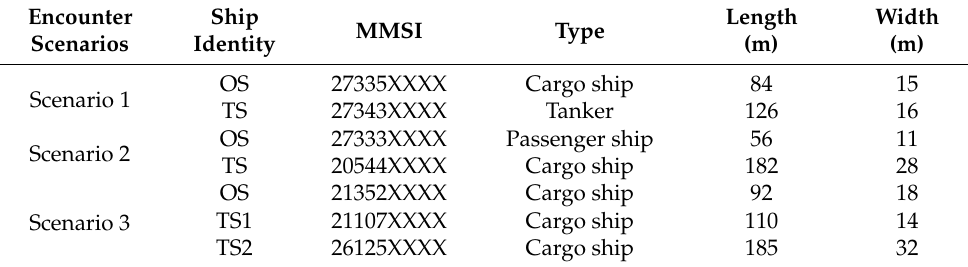
Table 3. Ship attributes in two typical encounter